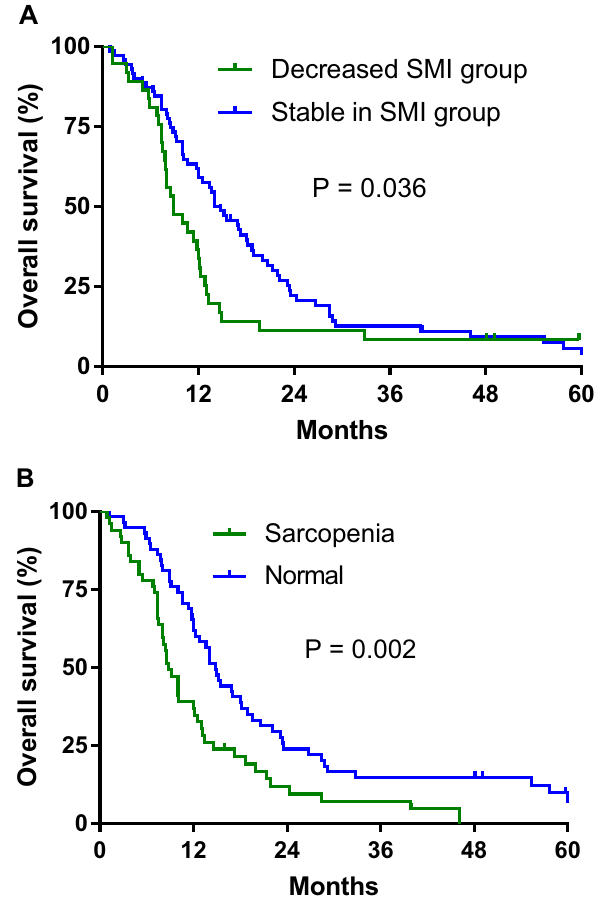
Figure. 1. Overall survival according to change in skeletal muscle index (SMI) from pre-chemotherapy to post- chemotherapy ( A ) and sarcopenia ( B ).